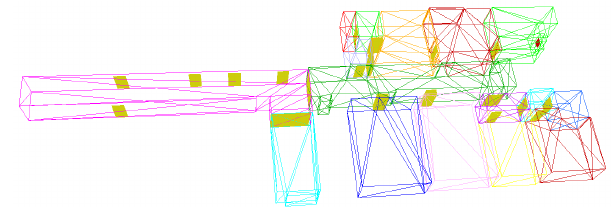
Figure 12. The structured model with openings.